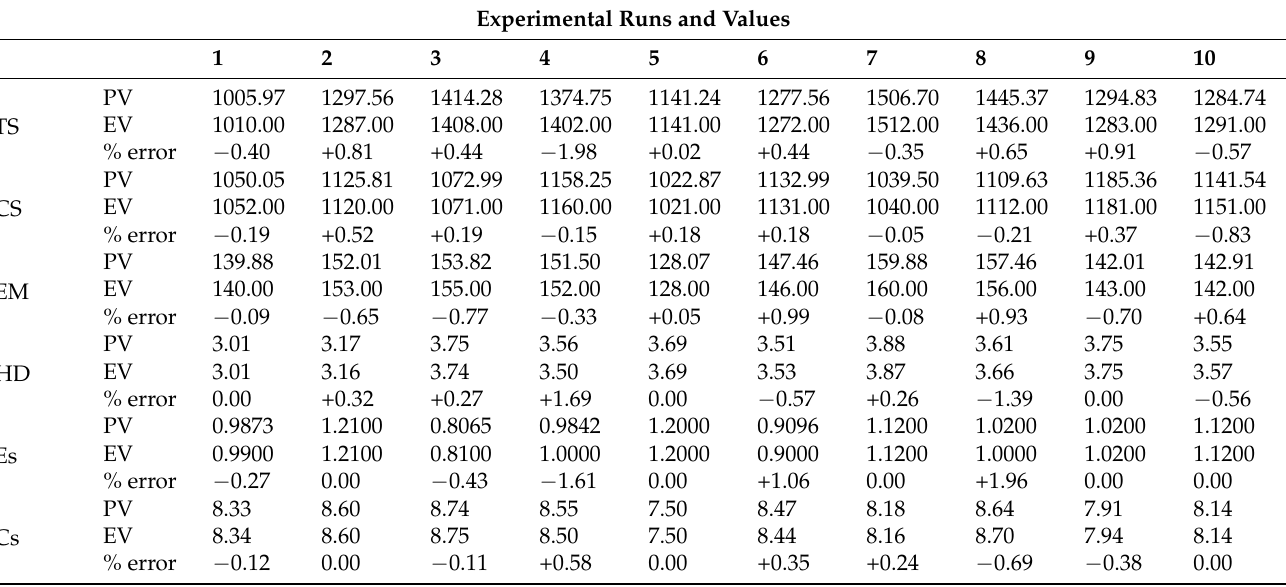
Table 3. Predicted and experimental values, and percentage error for the experimental